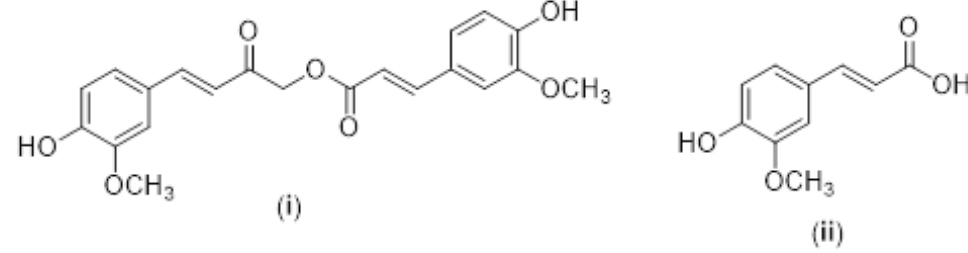
Figure 7. Structures of calebin A ( i ) and ferulic acid ( ii ).